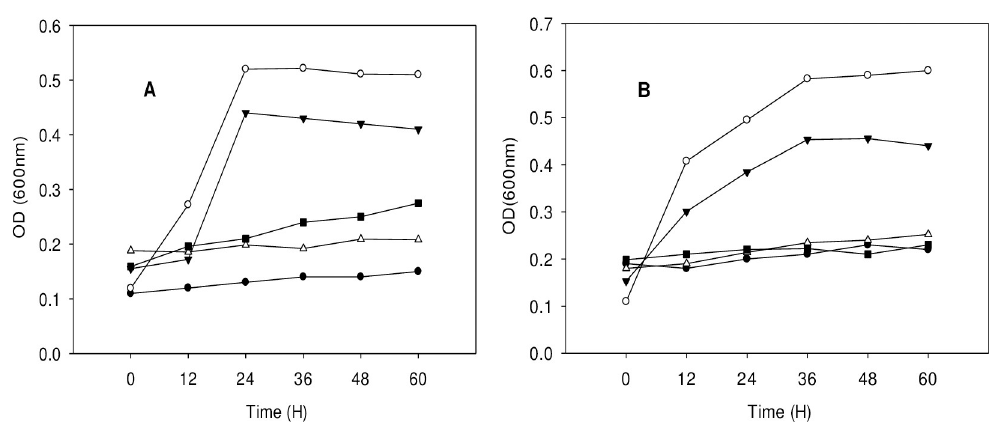
Fig 4. Proliferation of the strains under different pH; (A) Acinetobacter toweneri NTA1-2A, (B) Acinetobacter guillouiae TAT1-6A. Symbols: solid circle, pH 5; open circle, pH 6 ; solid triangle, pH 7; open triangle, pH 8; solid square, pH 9 at 31˚C and 1mM of 3MI concentration.